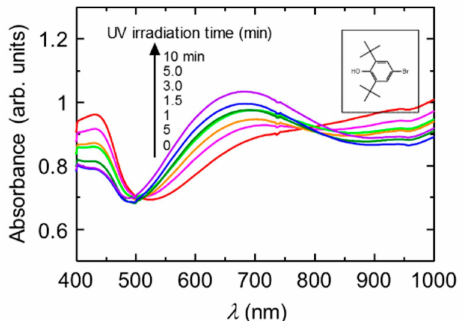
Figure 2. UV-vis absorption spectra of the PANI (0.01 M dispersion in the water) in the presence of 4-bromo-2,6-di- tert butyl phenol as a radical trap regent under UV light irradiation. Inset shows chemical structure of 4-bromo-2,6-di- tert butyl phenol.